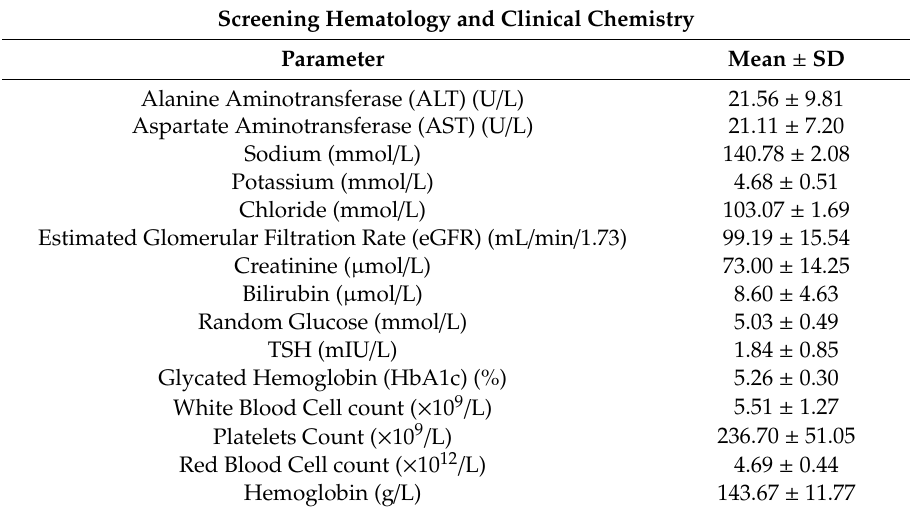
Table 3. Hematology and clinical chemistry markers for all participants enrolled ( n =